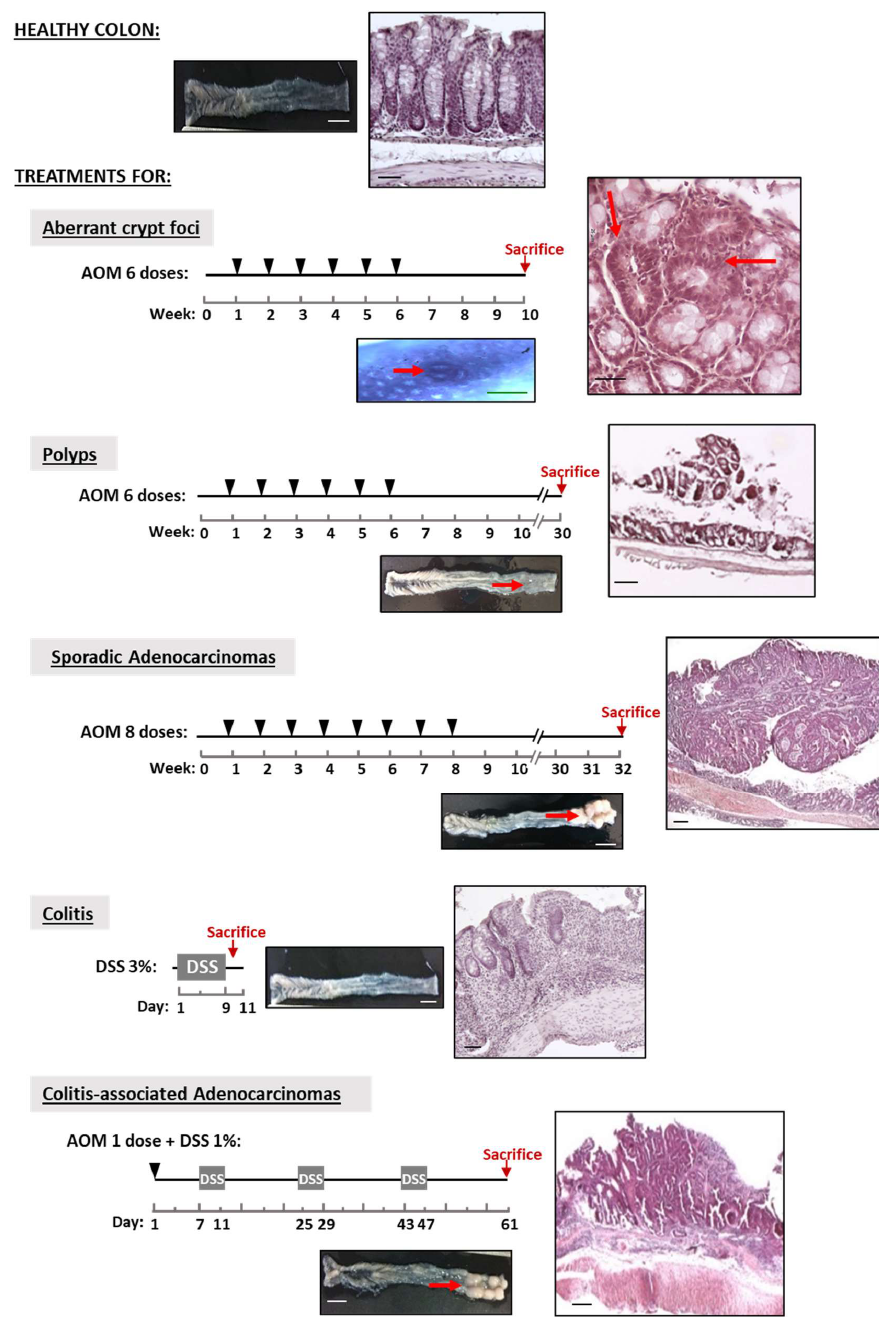
Figure 1. Mouse model of colon cancer progression. Experimental design of the treatments to induce lesions in the colon. Dextran sulfate sodium (DSS) was administered in the drinking water (3%) for 9 days to induce acute colitis. Azoxymethane (AOM) dissolved in PBS was administered by intraperitoneal injection at the point indicated by the arrowheads. DSS was administered in the drinking water (1%) in 4-day periods. Control groups (untreated mice) received PBS intraperitoneally and water orally. Representative photographs of mice colonic mucosa along colon cancer initiation and progression. Macroscopic (fresh tissue or stained with methylene blue solution in the case of aberrant crypt foci) and microscopic images (eosin–hematoxylin-stained sections) of mice colon with colitis, aberrant crypt foci, polyps, sporadic adenocarcinomas, colitis-associated adenocarcinomas and healthy colons (control groups). The lesions are indicated by red arrows. For each mouse model, the number of animals per experimental group was ten. White scale bars represent 1 cm, the green scale bar represents 50 µ m and black scale bars represent 200 µ